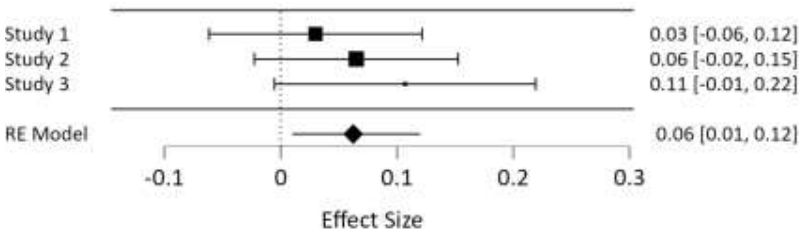
Figure 22. Forest plot of meta-analysis of Motivation for stimulation and Conscientiousness Motivation and L2 test success